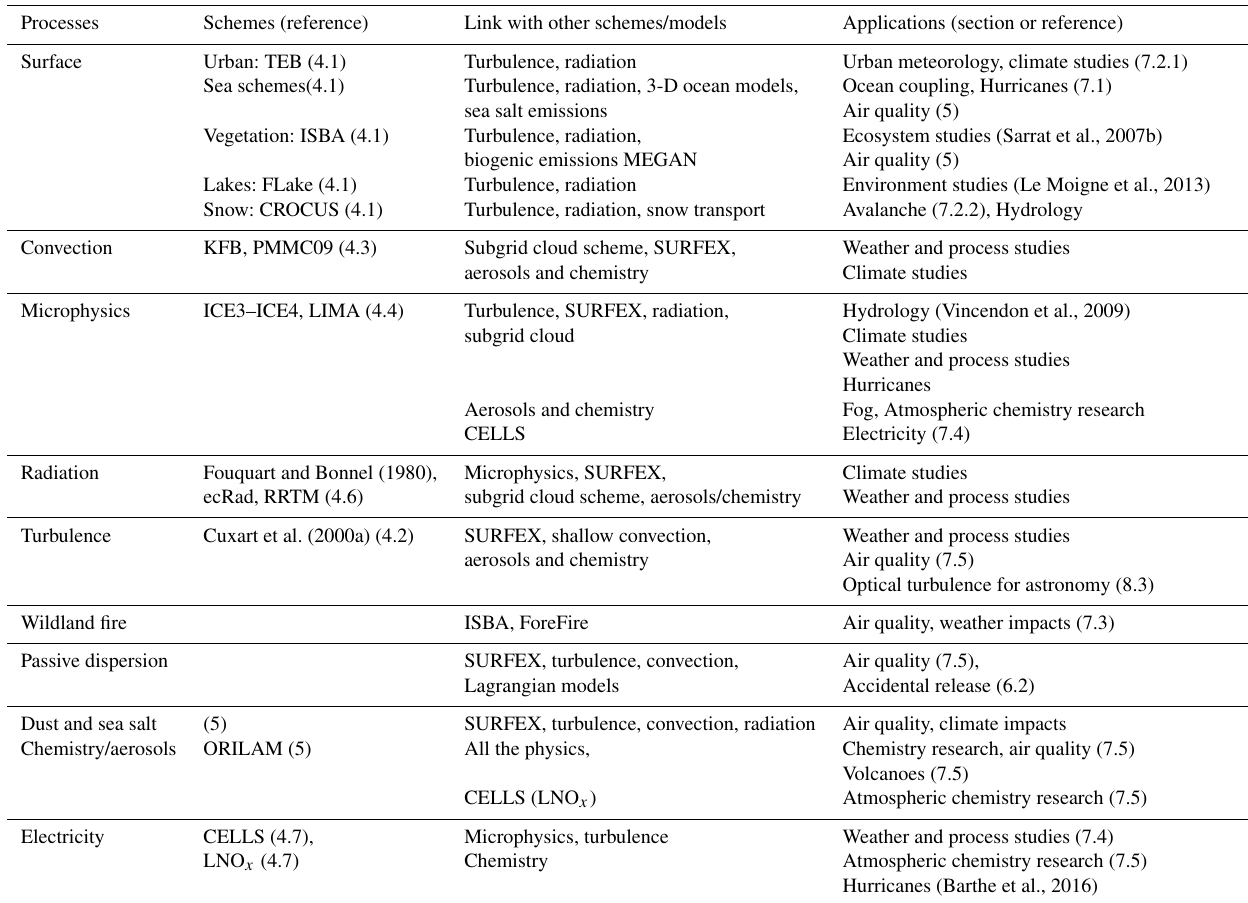
Table 4. Main capabilities and applications of Meso-NH version